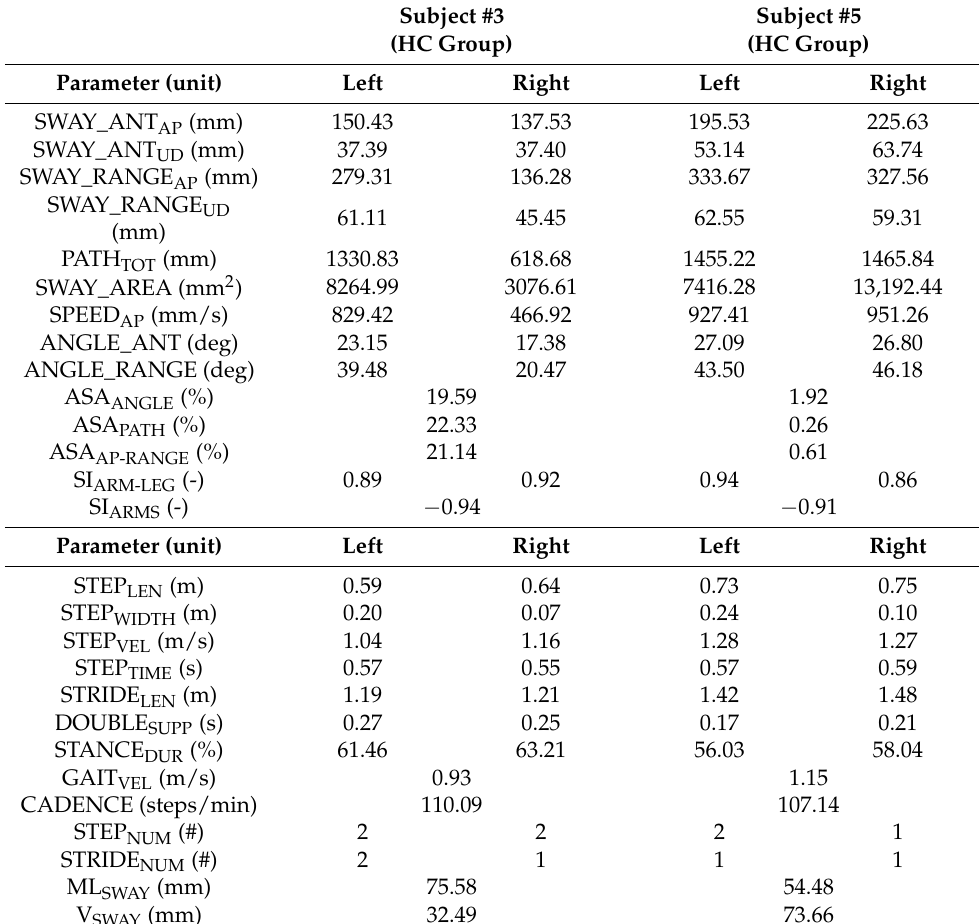
Table 7. A subset of the most representative parameters for the left and right sides related to the performance shown in Figure 3 (HC